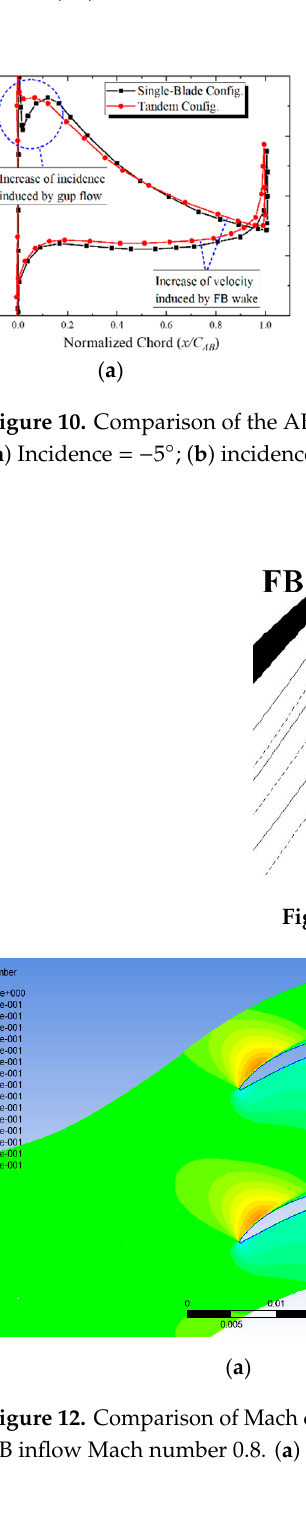
Figure 13. Comparison of Mach contours in single-blade and tandem configurations. FB incidence +5°; FB inflow Mach number 0.8. ( a ) AB single-blade configuration; ( b ) tandem configuration. 4. Optimization for Tandem Blades In this section, the “camber line modification method” was put forward to fully utilize the gap flow in subsonic tandem blades. Furthermore, this method was verified by carrying out the optimizations for both the 2D tandem blade model and a double-stage transonic compressor with tandem blades. In the following optimization results, we are concerned with two issues: (1) the flow mechanism of the camber line modification method’s influence on the blade element; (2) feasibility and validity of this method used in the optimization of 2D tandem blades and even compressors with tandem blades. 4.1. Optimization for a 2D Tandem Blade Model 4.1.1. The Optimization Procedure The simulation results for a baseline 2D tandem blade indicate that the typical CD airfoil achieved acceptable overall performance. However, some potential, improving directions are still being reflected in the comparison of isentropic Mach number distributions in single-blade and tandem configurations. It should be noted that the design parameters, such as AO/PP, solidity ratio, and camber ratio, were selected during a proper interval in the preliminary design, and they are kept fixed during the optimizing process. The camber line and blade angle were modified to adapt to